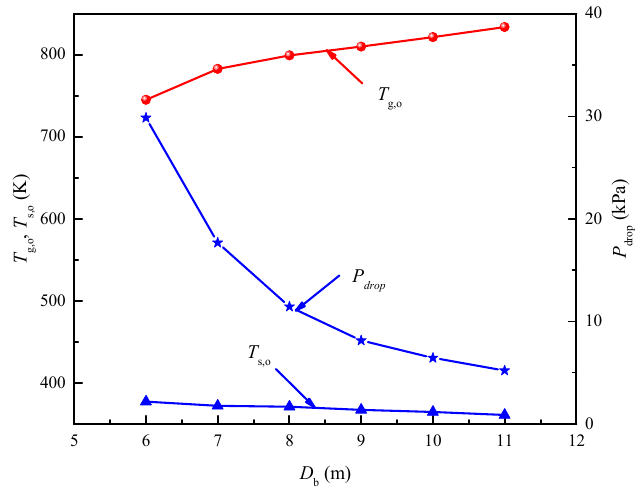
Figure 11. Effects of the diameter of the sinter bed on the air and sinter outlet temperatures and the pressure drop of cooling air.